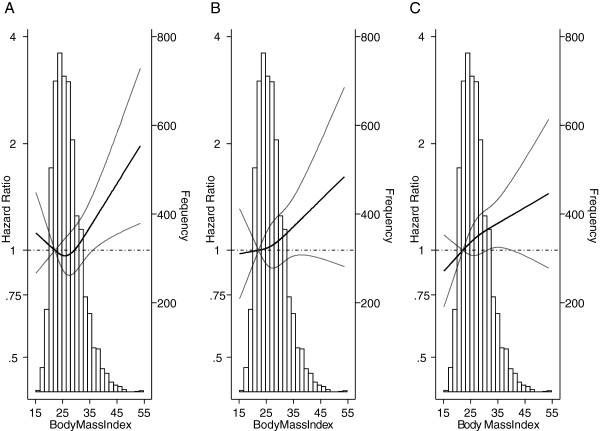
Hazard ratio dose–response curve (dark line) and upper and lower limits of the confidence interval (lighter lines) for body mass index for each survival outcome. (A) Overall Mortality. (B) Breast cancer mortality. (C) Recurrence. Estimates were adjusted for all the variables in the full model.